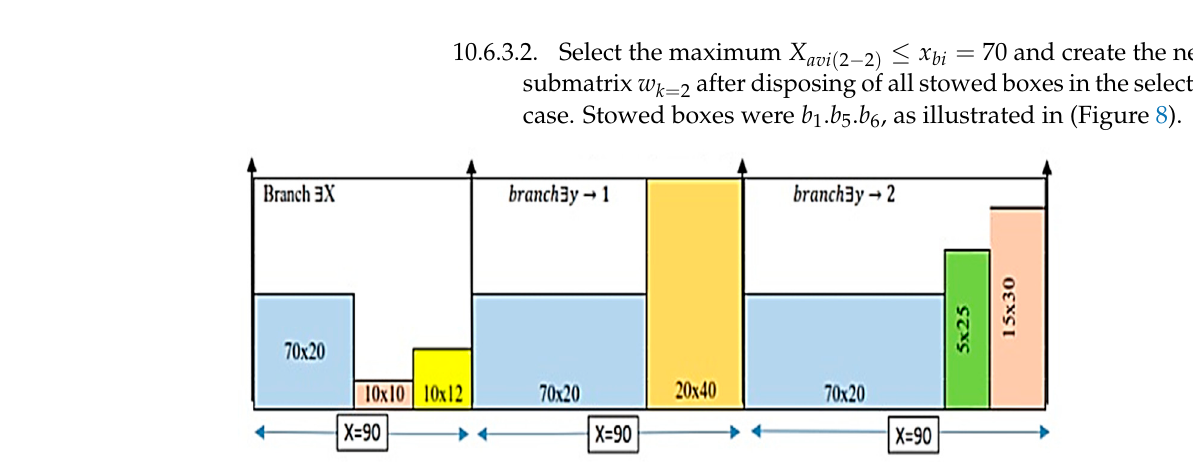
Table 9. Branch and bound for bi at X avi <70.